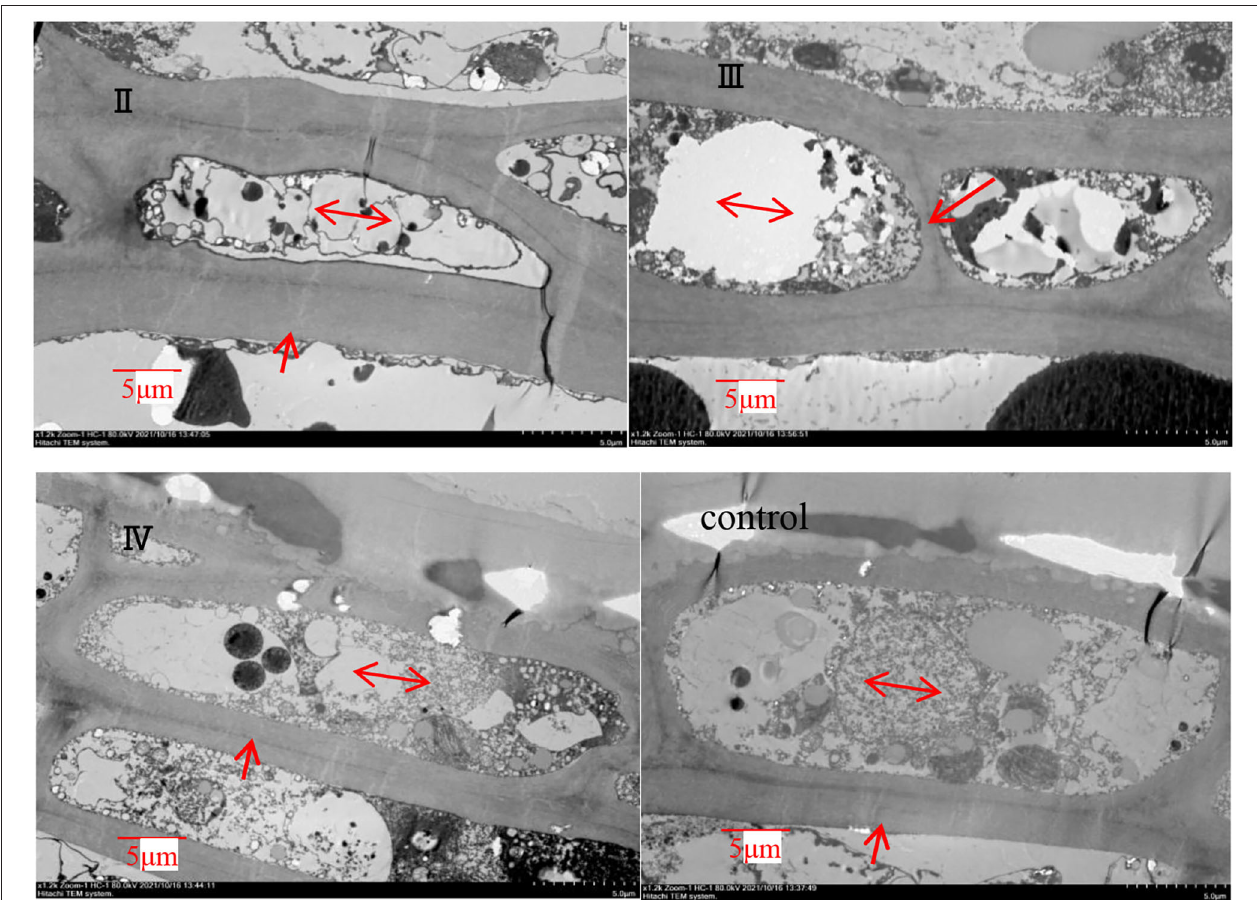
FIGURE 6 | TEM of grape peels with calcium treatment in different stages (II represents ripening grape skins treated with calcium spray at flowering, III represents ripe grape skins treated with calcium spray during fruit development, and IV represents ripe grape skins treated with calcium spray at the end of fruit development) (cell wall, arrows; cell volume, double